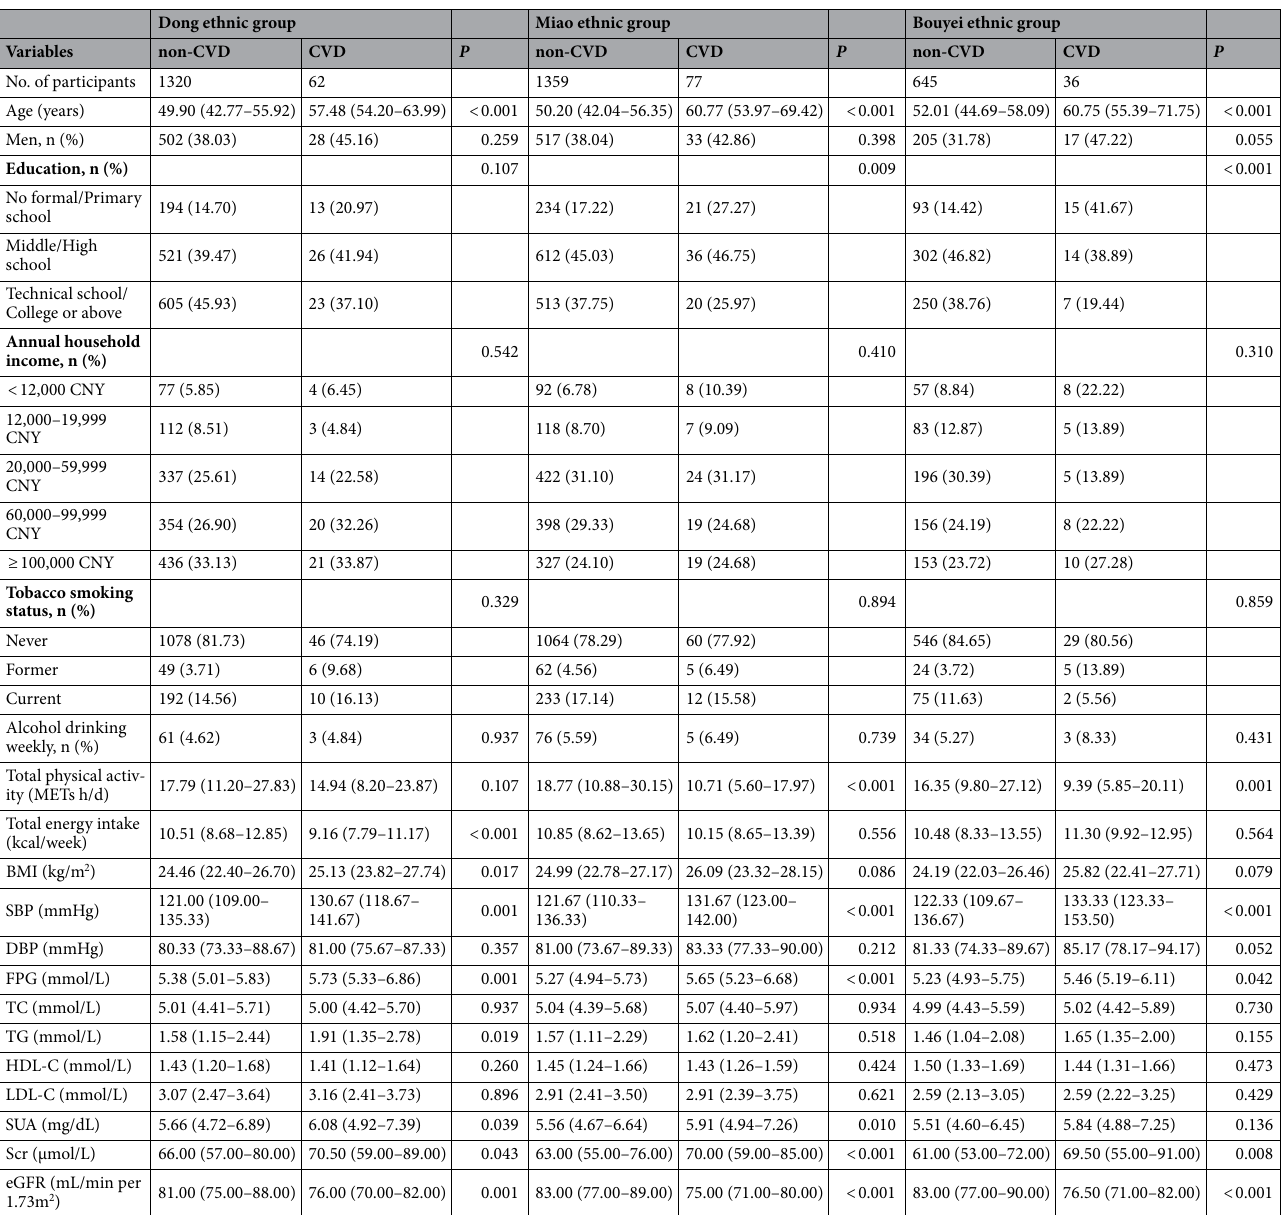
Table 2. Basic characteristics of the Dong, Miao, and Bouyei ethnic groups by cardiovascular disease status in urban areas. BMI body mass index; CNY Chinese Yuan; CVD cardiovascular disease; DBP diastolic blood pressure; eGFR estimated glomerular filtration rate; FPG fasting plasma glucose; HDL-C high-density lipoprotein-cholesterol; LDL-C low-density lipoprotein-cholesterol; METs h/d metabolic equivalent tasks hours/day; SBP systolic blood pressure; Scr Serum creatinine; SUA serum uric acid; TC total cholesterol; TG triglycerides. Data are presented as number (percentage) for categorical variables and median (interquartile range) for continuous variables. P comparing non-CVD and